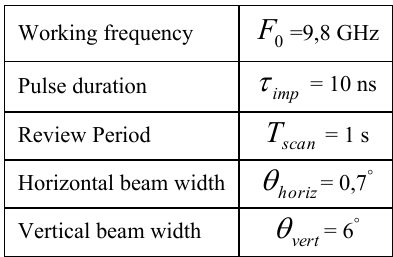
Table 1. Main technical characteristics of the UPS airfield surveillance